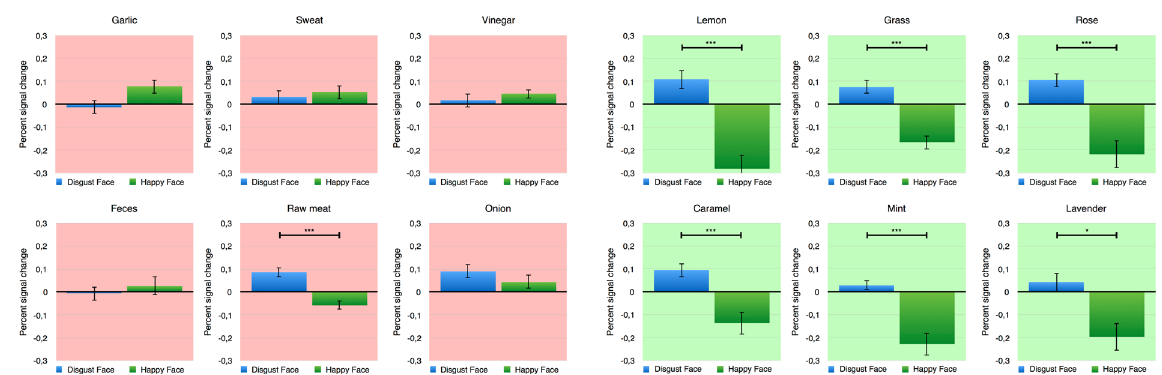
Figure 5. Integration effects of facial expressions to odor perception on activation in the right piriform cortex for single odors. The effect can be found for all pleasant odors but not for unpleasant odors except raw meat. * Signifies a statistically significant difference at the threshold 0.05 and *** signifies a statistically significant difference at the threshold